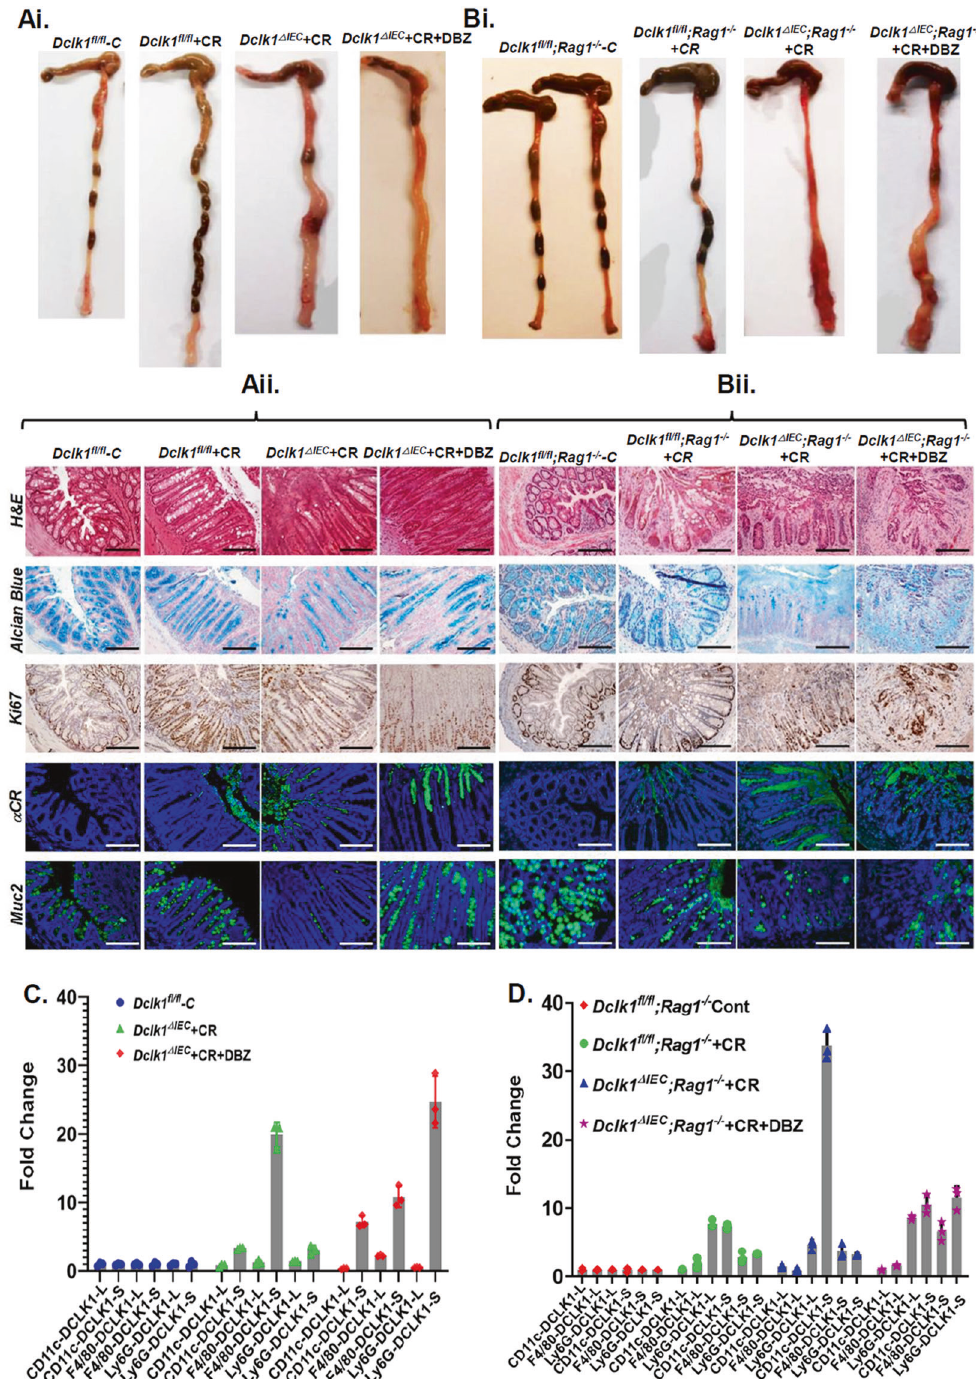
Fig. 7 Effect of DCLK1 deletion on mucosal in fl ammation and colitis. Control ( fl oxed) or intestinal epithelial cell-speci fi c DCLK1-KO ( DCLK1 Δ IEC ) or DCLK1 Δ IEC ;Rag-1 − / − double KO (DKO) mice were infected with CR and given single doses of DBZ. Ai , Bi Gross thickening and ulceration of the colon in the two transgenic lines. Aii , Bii Representative histology (H&E) or immunostaining in the paraf fi n-embedded sections prepared from the distal colons of the indicated mouse groups. Alcian blue and Ki-67 labeling represents goblet and proliferating cells, respectively. Anti-CR- and α -Muc2-stained Citrobacter rodentium and Muc-2, respectively ( n = 6 mice/group; Scale bar: 100 μ m). C , D Immune cells were FACS-sorted with antibodies against CD11c, F4/80, and Ly6G from the crypt-denuded lamina propria of the indicated groups of mice and the expression of the two isoforms of DCLK1 were measured by RT-qPCR. The values were normalized to GAPDH, and data are presented as fold change. P values for C based on signi fi cance: 0.000033 (CD11c: DCLK1-S), 0.000057 (F4/80: DCLK1-S), 0.013 (Ly6G: DCLK1- L), 0.0081 (Ly6G: DCLK1-S). P values for D based on signi fi cance: 0.000035 (CD11c: DCLK1-S), 0.016 (F4/80: DCLK1-S), <0.000001 (Ly6G: DCLK1- S); n = 3 independent